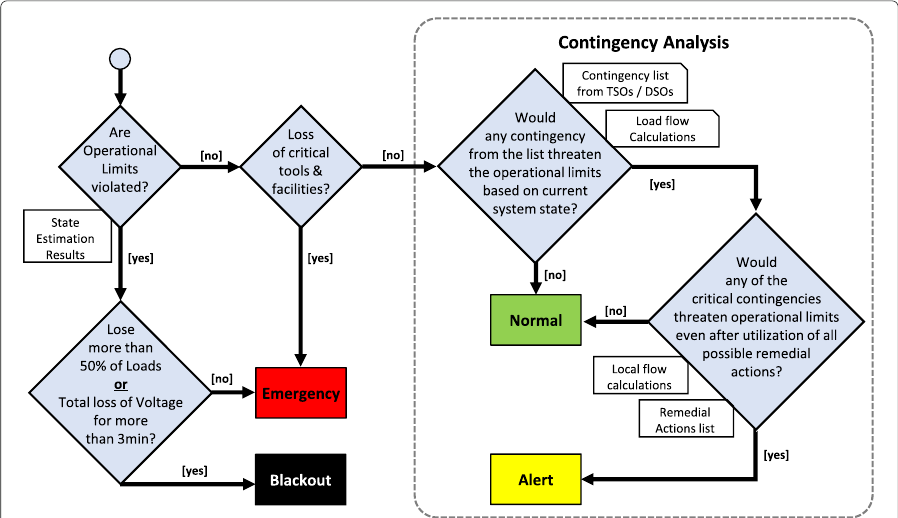
Fig. 2 Flowchart of ENTSO-E State Identification Process focusing on Contingency